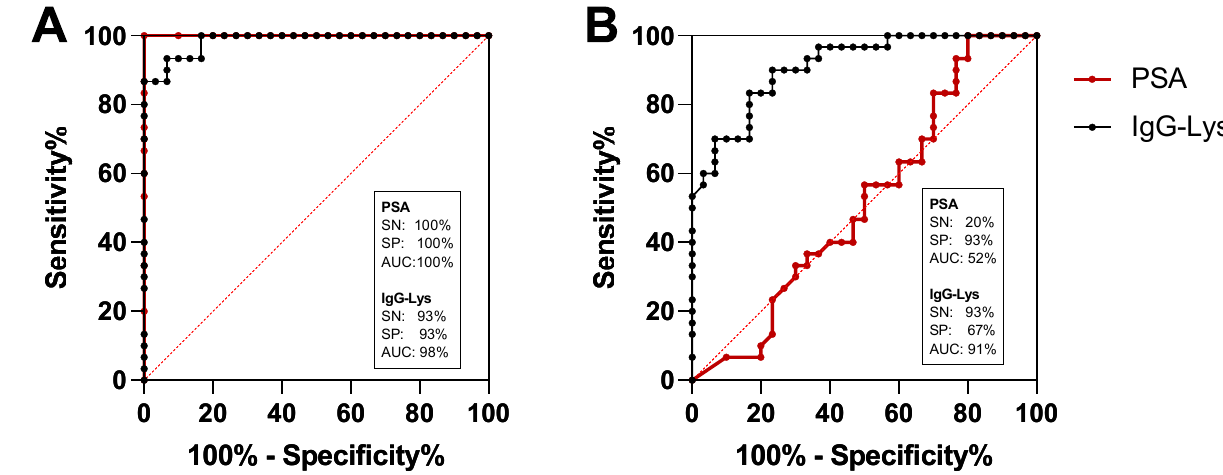
Figure 8. ROC analysis of serum IgG-Lys vs. tPSA in patients with PC vs. healthy donors ( A ), and PC vs. BPH ( B ).